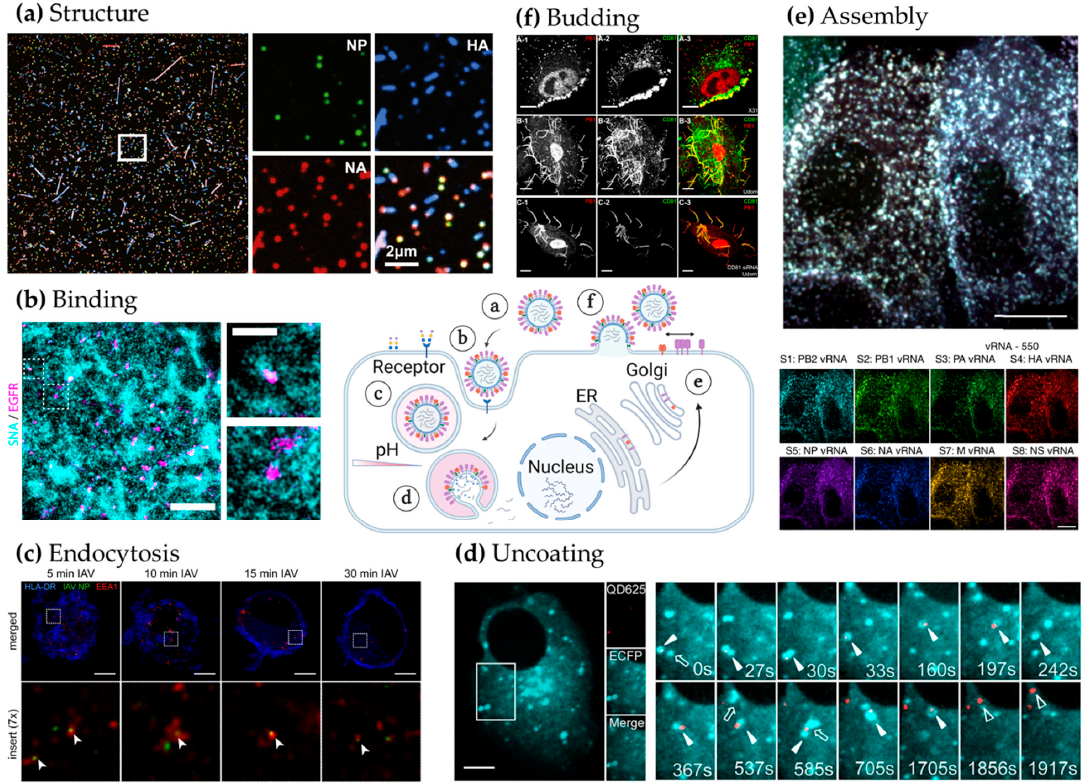
Figure 3. Analysis of influenza virus replication using advanced microscopy. Scheme of the influenza life cycle and corresponding microscopy images showing, anti ‐ clockwise: ( a ) Virus particle structure and composition: Spherical and filamentous influenza virions labelled for NP (green), HA (blue) and NA (red) and immobilized on a coverslip exhibit diverse morphologies and composition. Adapted from [22]. ( b ) Binding: Left: Two ‐ colour STORM image of A549 cells labelled for sialic acid (SNA) (blue) and anti ‐ EGFR (magenta). Scale bar: 500 nm. Right: insert of left. Scale bar: 200 nm. Adapted from [26]. ( c ) Endocytosis: STED images of dendritic cells labelled for HLA ‐ DR (blue), influenza virus NP (green) and EEA1 (red). Arrows point to nanoscale colocalization of EEA1 and NP signals. Scale bar: 5 μ m. Adapted from [28]. ( d ) Uncoating: MDCK cells expressing Rab7 ‐ ECFP (blue) infected with influenza vRNPs labelled with a quantum dot QD625 (red). Scale bar: 5 μ m. Snapshots of tracked influenza and Rab7 over time. Filled triangles: colocalization of QD and Rab7 signals, hollow triangles: released vRNPs, arrows: virus ‐ negative endosomes. Adapted from [64]. ( e ) Assembly: bottom: each of the 8 segments of viral genomic RNA is visualised by FISH using Atto550 as label. Top: overlay. Scale bar: 10 μ m. Adapted from [75]. ( f ) Budding: Top row: A549 cells were infected with influenza virus X ‐ 31 for 16 h and labelled with anti ‐ CD81 (green) and anti ‐ PB1 (red). CD81 is recruited to the virus budding zone in X ‐ 31 infected cells. Middle row: A549 cells infected with Udorn virus. Same staining as top. CD81 is incorporated into budding filamentous virions of Udorn ‐ infected cells. Bottom row: same as middle row, but in CD81 ‐ KO cells. Remaining CD81 in CD81 ‐ KO cells is incorporated into budding filamentous viruses of Udorn infected cells. Scale bar: 10 μ m. Adapted from [76].